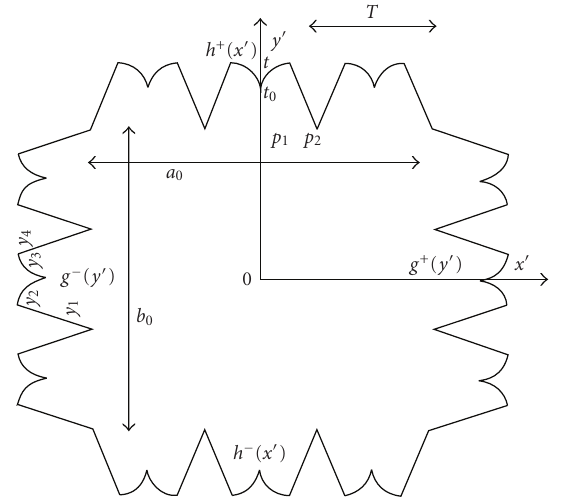
Figure 1: Square aperture reflector with NISE-convex serrations.